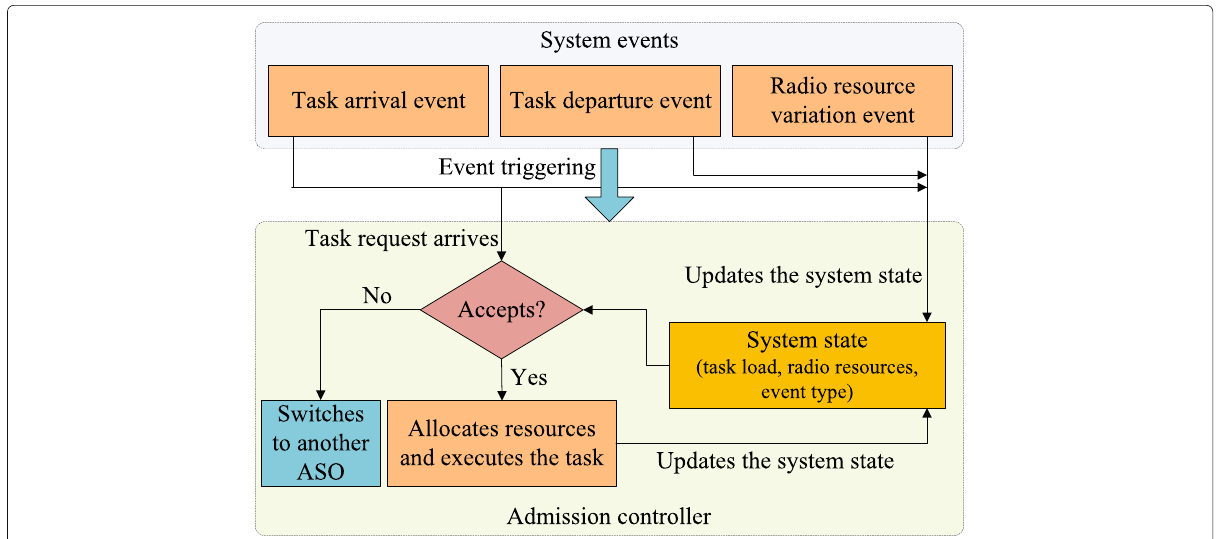
Fig. 2 Task admission control model. The task admission control model is abstracted as the model shown in this figure. The admission controller decides whether to accept the task request according to the system state when a task request arrives. If the task is accepted, the ASO allocates resources and executes the